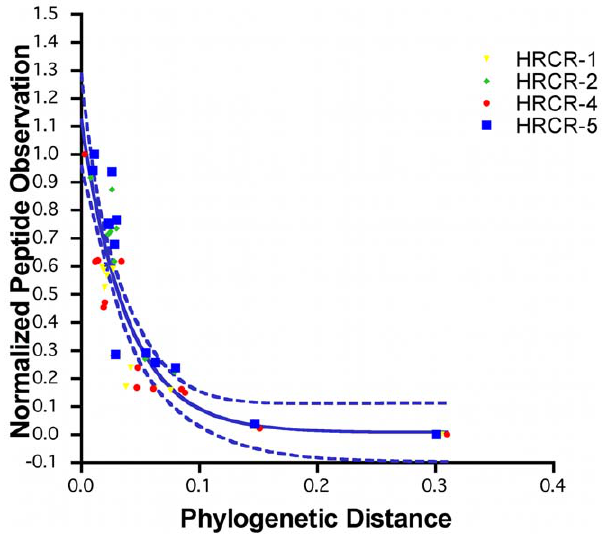
Figure 3. The number of peptides observed from the Columbia River Shewanella isolates graphed against evolutionary dis- tance. The resulting trend agrees with the trend observed from characterized Shewanella species.